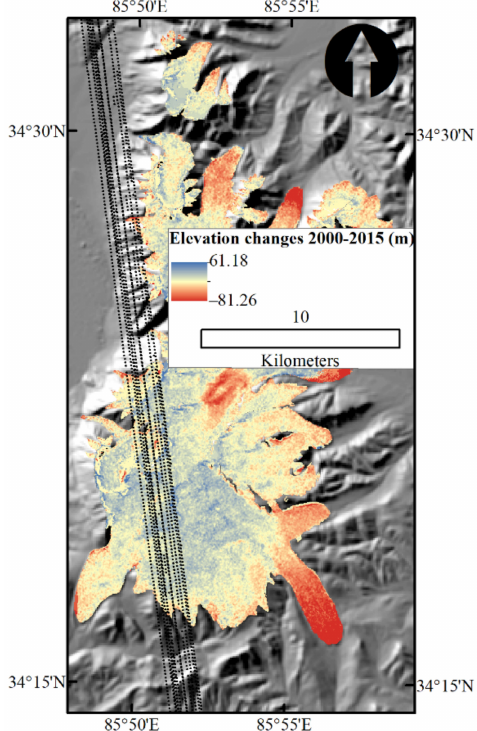
Figure A10. Ice, Cloud, and land Elevation Satellite (ICESat) points on the difference map between SRTM and HMA. Most ICESat points that lie on glaciers are in the accumulation